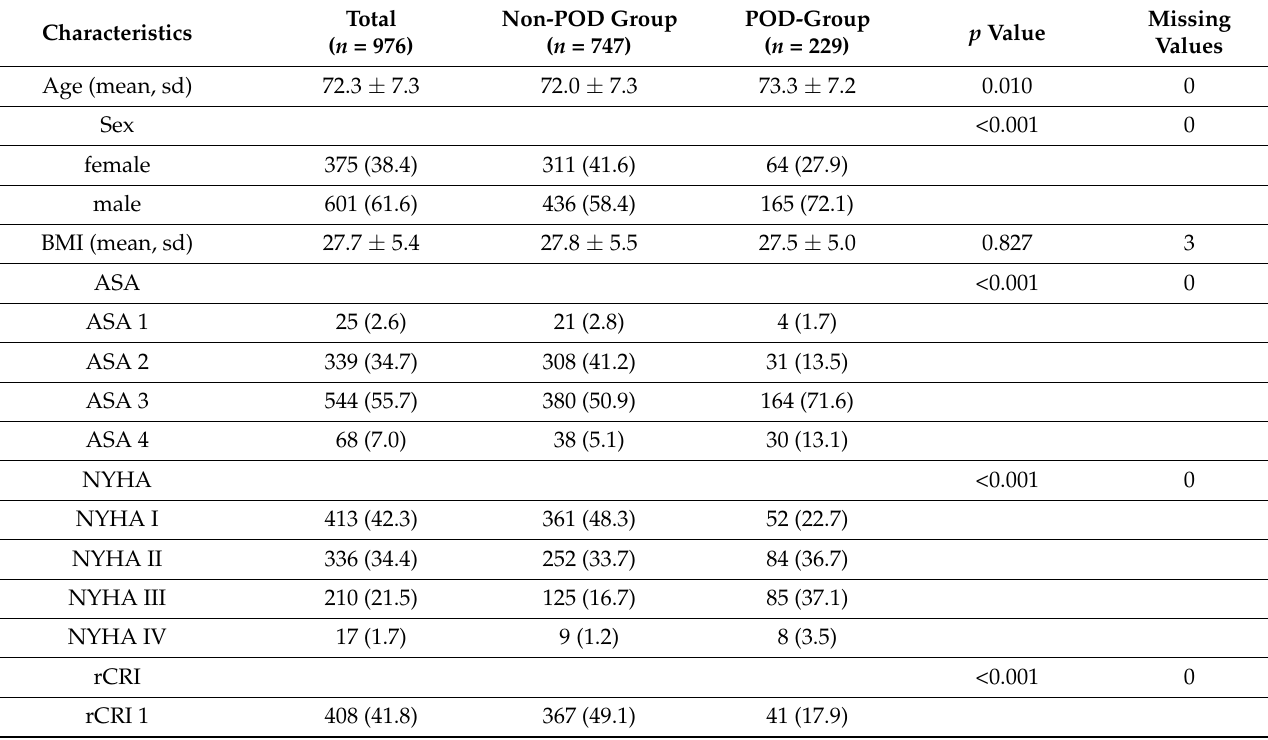
Table 1. Characteristics variables related to POD.